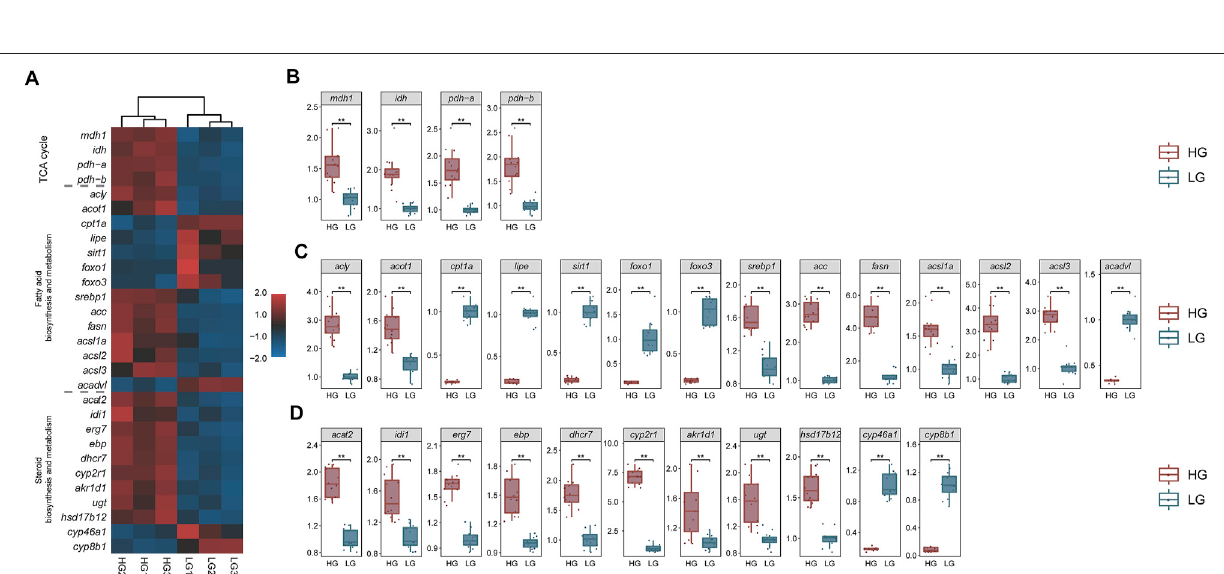
FIGURE 10 | Transcriptome transcripts per million (TPM) values ( n = 3) and qRT-PCR results of key genes ( n = 12). (A) Heat map of transcriptome TPM values of key genes; mRNA levels of key genes in (B) the “ TCA cycle pathway ” , (C) the “ fatty acid biosynthesis and metabolism pathway ” , and (D) the “ cholesterol biosynthesis and metabolism pathway ” . ** p <